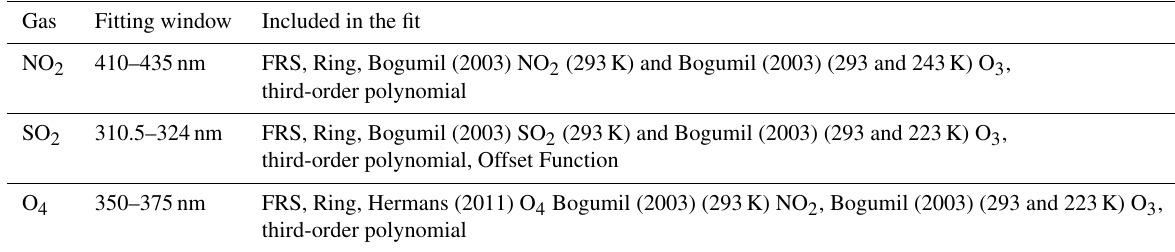
Table 2. Information on MAX-DOAS spectral